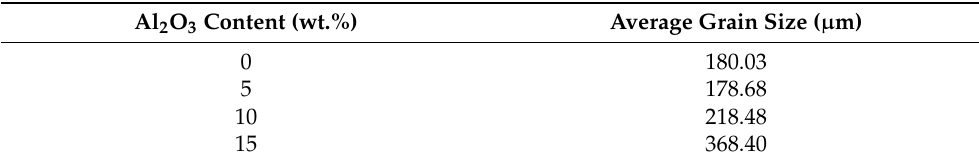
Table 1. Average grain size for the Mg-Zn/HAP/Al 2 O 3 composite. Al 2 O 3 Content (wt.%)